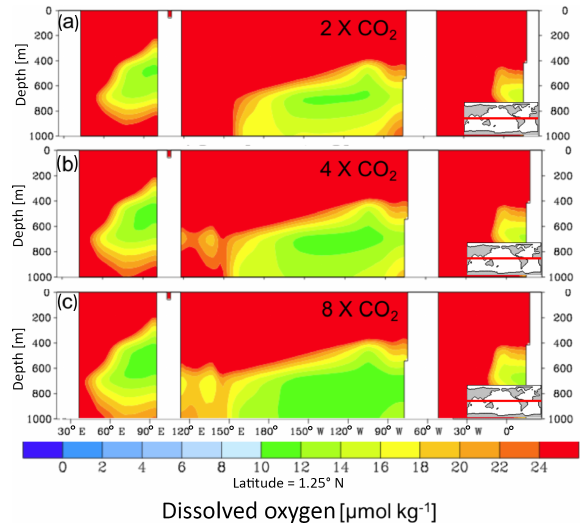
Figure 8. Zonal cross section at 1.25 ◦ N of the formation of the western tropical Pacific OMZ for the (a) 2 × , (b) 4 × and (c) 8 × CO 2 simulations. The OMZ core is located between 130 and 150 ◦